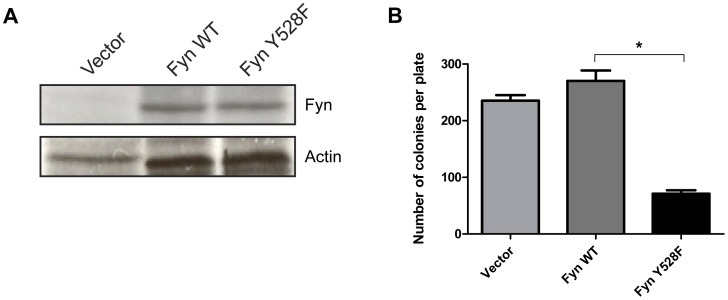
Overexpression of active Fyn decreases clonogenicity in the absence of BCR-ABL1.(A) Bone marrow cells from Fyn knockout mice were transduced with vector, wild-type Fyn (Fyn WT), or constitutively active Fyn (Fyn Y528F). Expression of wild-type and constitutively active Fyn was detected in total protein lysates (100 µg) using a Fyn specific antibody. Actin was used as a loading control. The blot is representative of three independent experiments. (B) Fyn reconstituted bone marrow cells were suspended in MethoCult GF H4434 medium and colonies were counted five days after plating. *p<0.001, n = 3, mean+SEM.